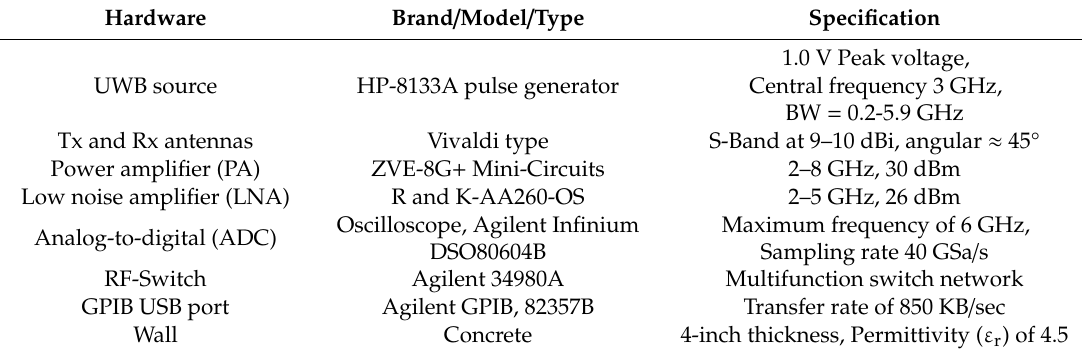
Table 3. Descriptions of the experimental